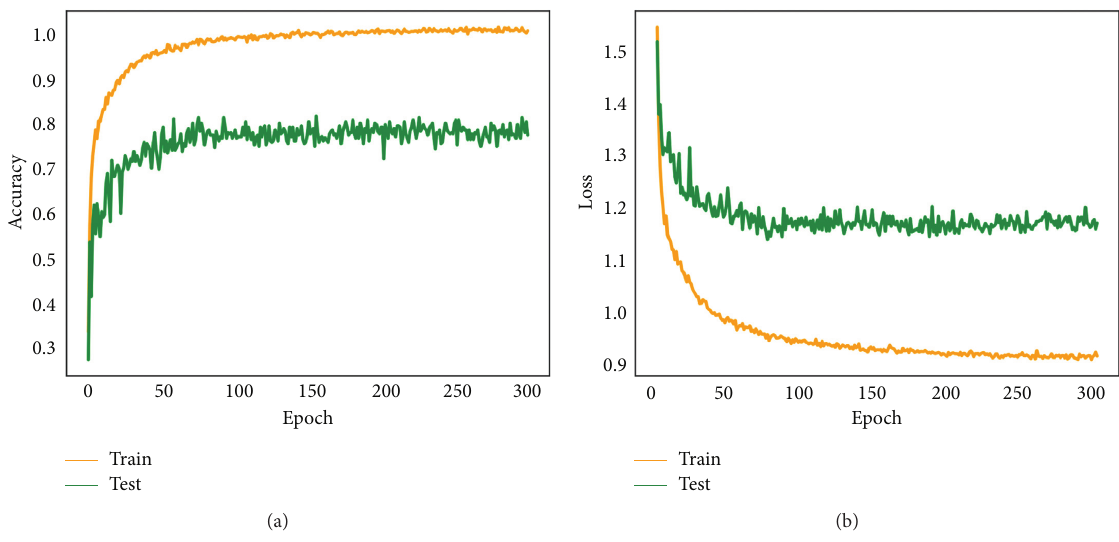
Figure 7: Training process of SOCNN: (a) change in ACC in training; (b) change in loss in training.